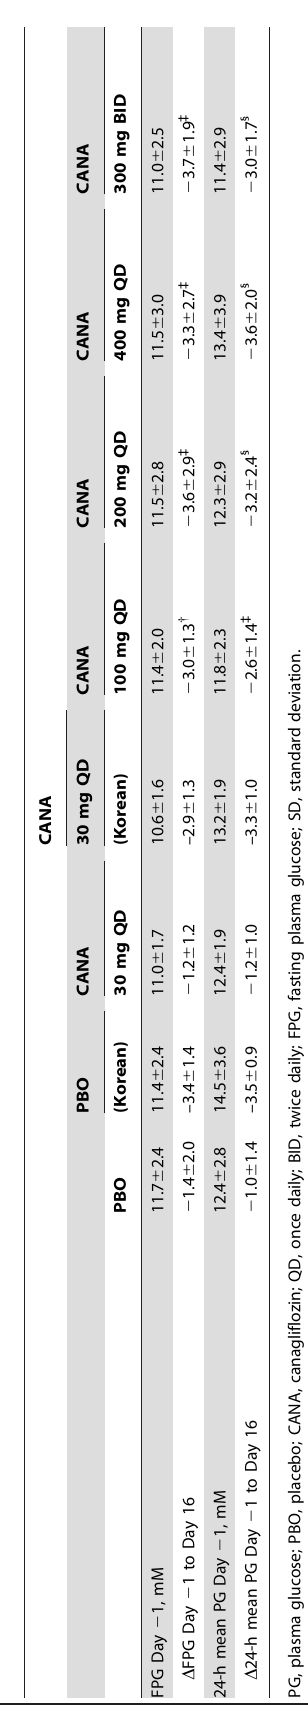
24 h = 6.4 mM [124.5 mg/dL]) for the 100 mg dose on Day